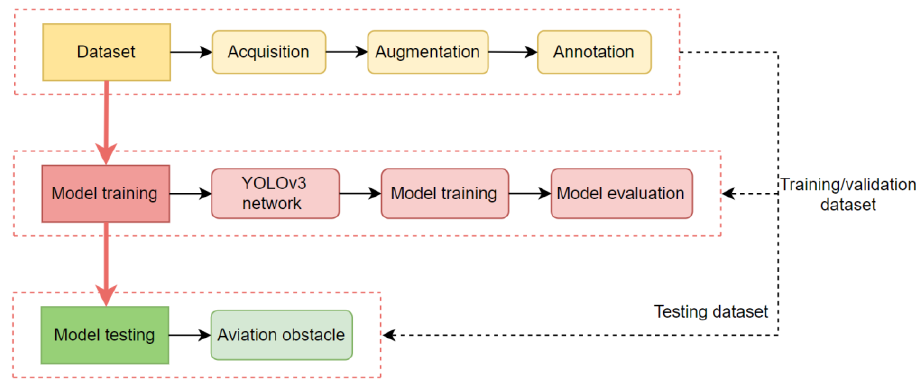
Figure 2. Overall architecture of the proposed